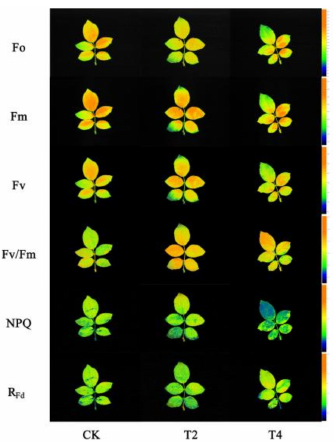
Figure 1. Effects of calcium treatment during heat stress on chlorophyll fluorescence parameters of ‘Carolla’ treated with 100 µ M CaCl 2 (T2), 200 µ M CaCl 2 (T4), or H 2 O as the control